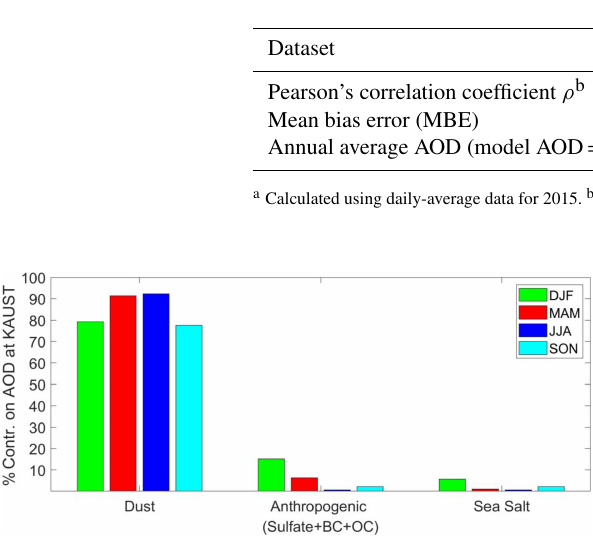
Table 2. Statistics a of simulated AOD compared with different observations at KAUST.